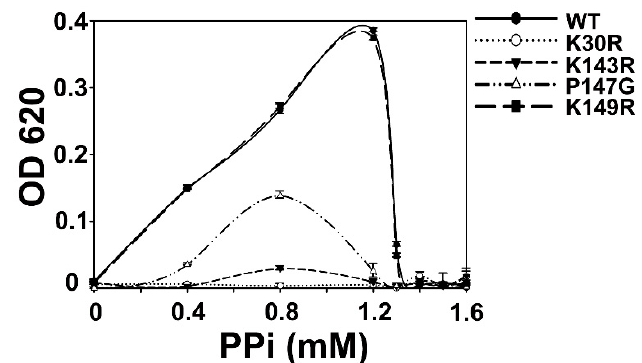
Figure 6. Enzyme assay of WT and four variants of AbPPase. The K149R variant had a similar activity as the WT AbPPase, K30R and K143R variants lost almost all their activity, and the P147G variant had a significantly reduced activity compared to the WT AbPPase. Error bars represent standard deviations for n = 3 independent experiments.